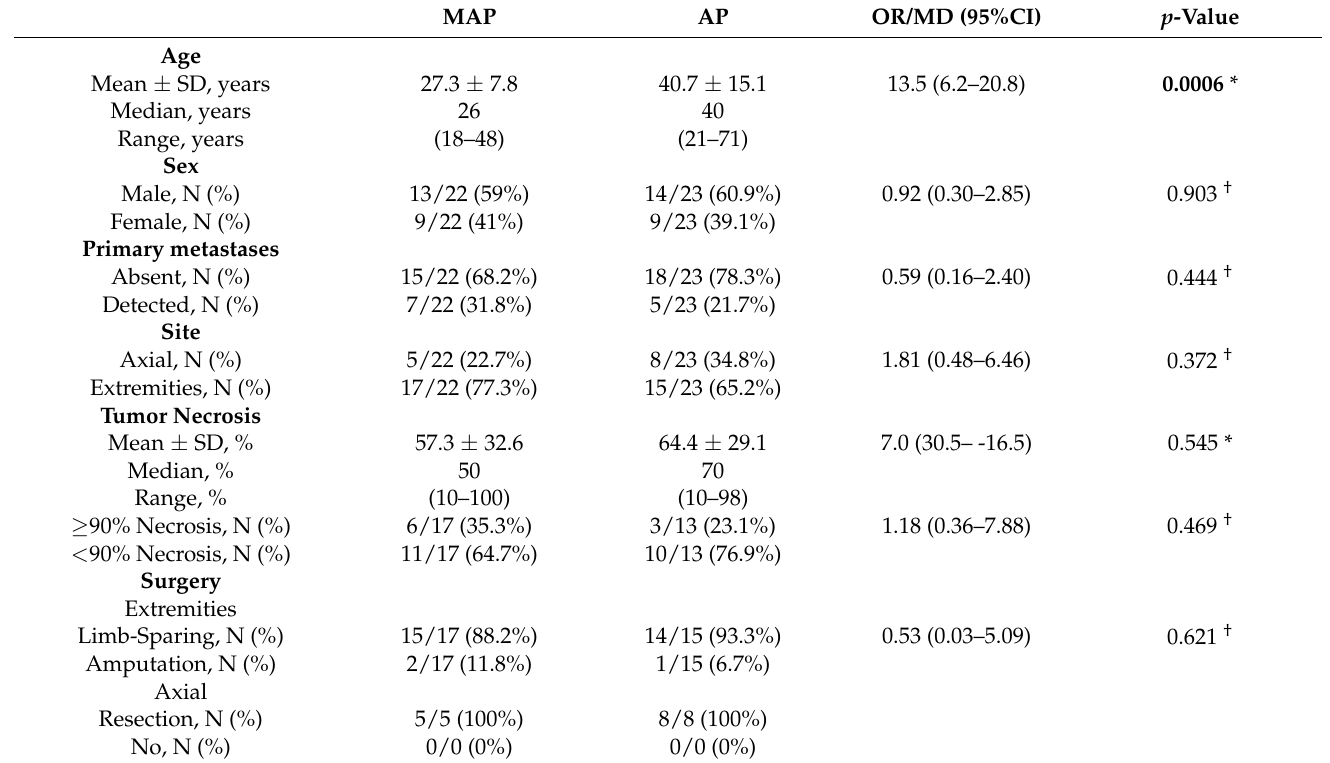
Table 2. MAP vs. AP chemotherapy in the adult cohort.